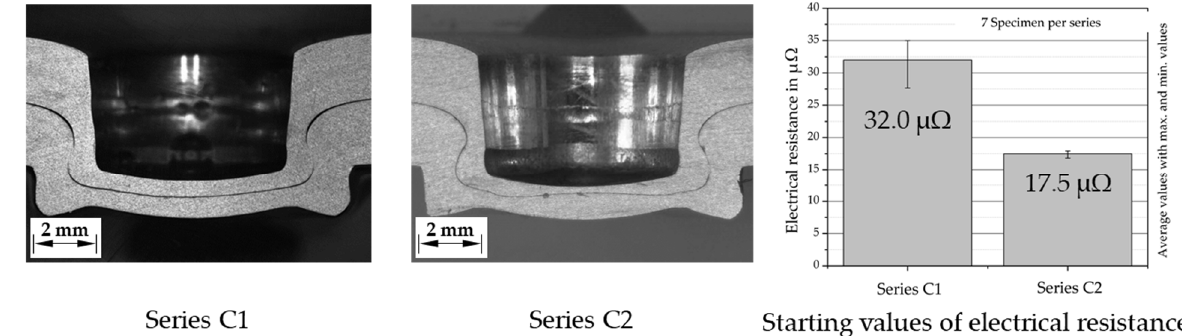
Figure 5. Cross-section of investigated clinch joints and electrical joint resistance.